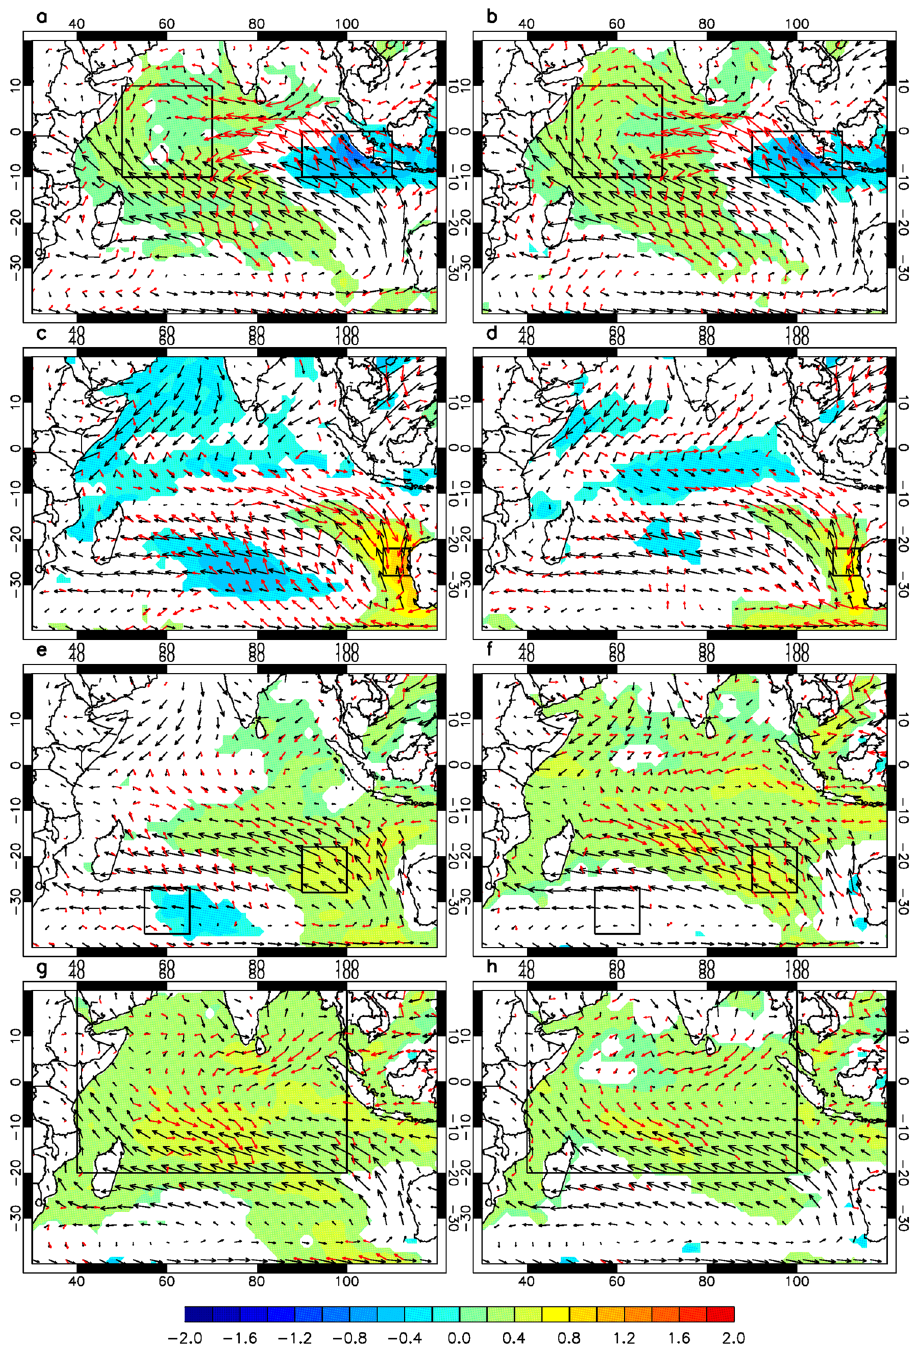
Figure 3. The composite maps of anomalous SST and 10 m wind field during, ( a ) Sep.–Nov. for all positive IODMs, ( b ) same as ( a ) except for El Niño, ( c ) Jan.–Mar. for all positive Ningaloo Niño, ( d ) same as ( c ) except for La Niña, ( e ) Feb.–Apr. for all negative SIODs, ( f ) same as ( e ) except for El Niño, ( g ) Mar.–May for all positive IOBM, ( h ) same as ( g ) except for El Niño. The climatological /anomalous winds are is indicated by black/red arrows. The regions with the SST anomalies exceeding 90% confidence level are shaded, and red arrows exceed 90% confidence